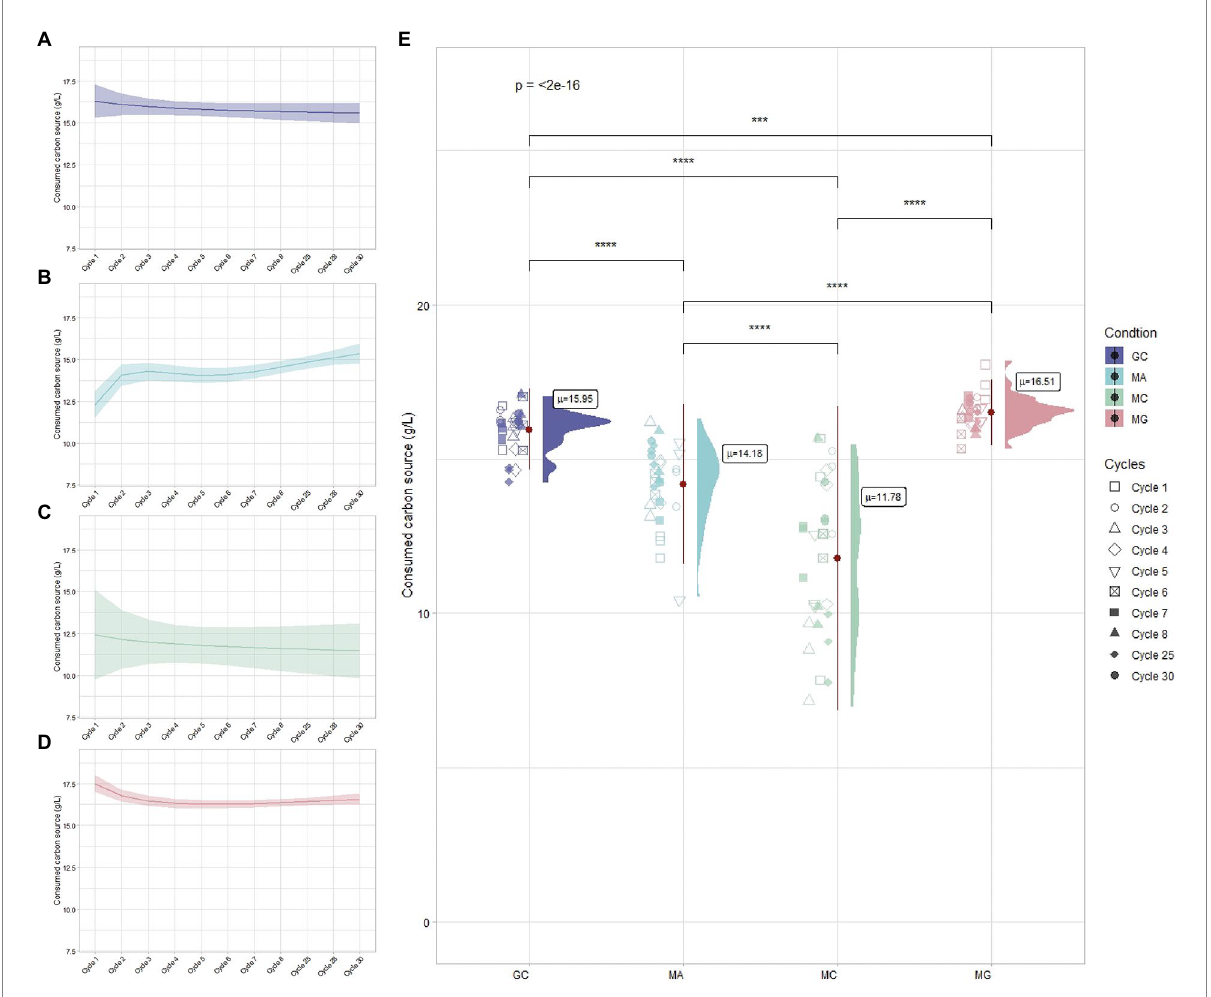
FIGURE 3 Carbon source utilization during the ALE cycles for (A) GC, (B) MA, (C) MC, and (D) MG conditions. (E) Overall carbon source consumption among conditions: each points represents the carbon source replicates related to the cycle and “ μ ” indicates the average consumption of carbon source among tested cycles.